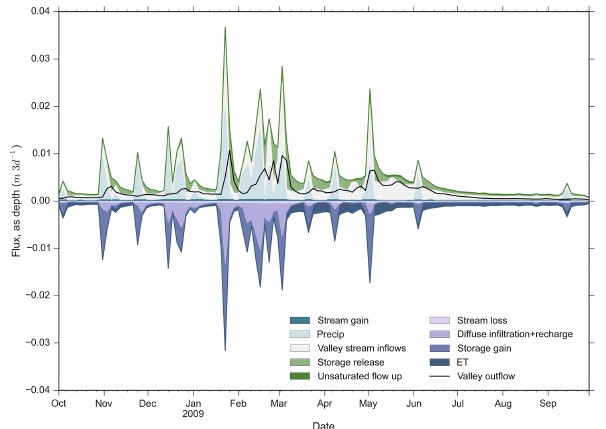
Figure 8. A 3-day simulated surface water budget time series, pre- sented as components of the resulting outflowing stream hydro- graph. Flow values shown as depth in meters per 3-day period, nor- malized by simulated Central Valley area. Positive values represent flow that potentially contributes to streamflow. Negative values rep- resent flow that potentially reduces streamflow.